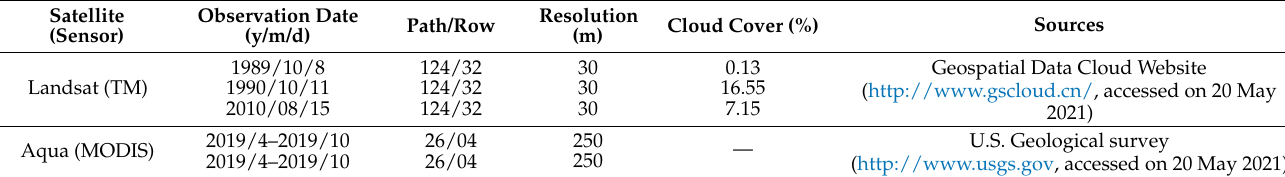
Table 2. Remote sensing images used for land use